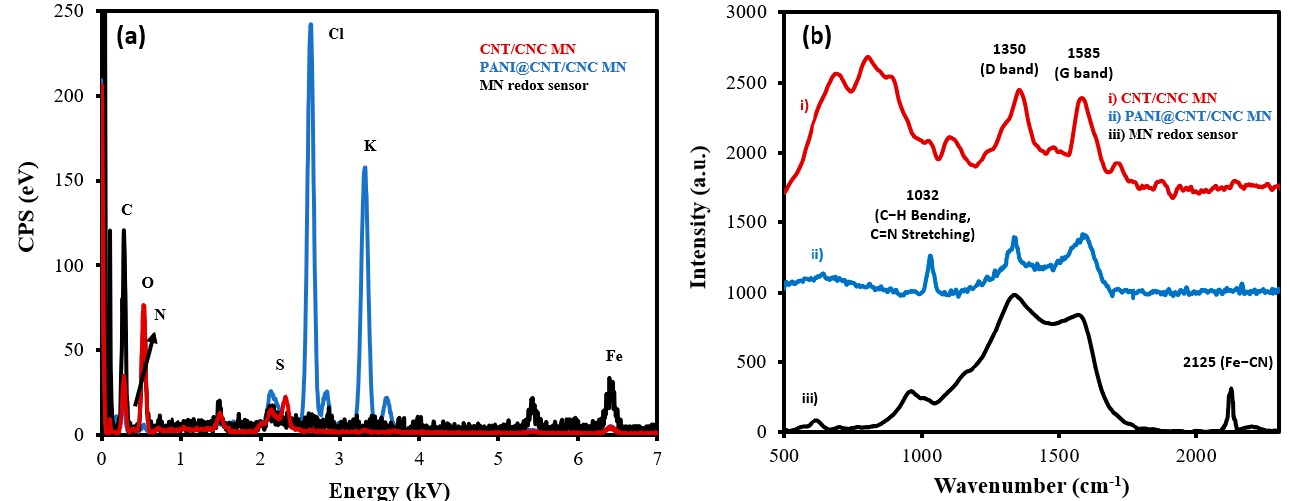
Figure 3. Overlapped ( a ) EDS and ( b ) Raman spectra taken from (i) CNT/CNC microneedle (MN); (ii) PANI@CNT/CNC MN; and (iii) MN redox sensor.